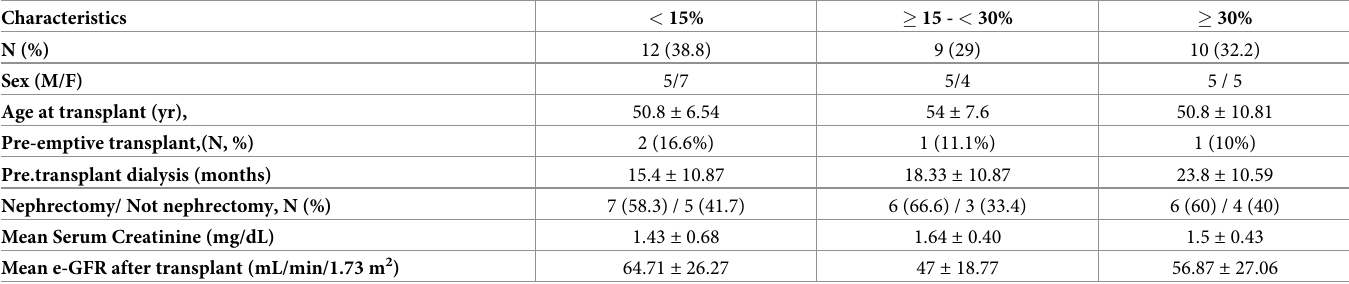
Table 2. Patients with longitudinal kidney diameters decrease divided into 3 subgroups according to the rate of decrease. In patients with different variation in size of the two kidneys, it was considered the kidney with the highest variation.